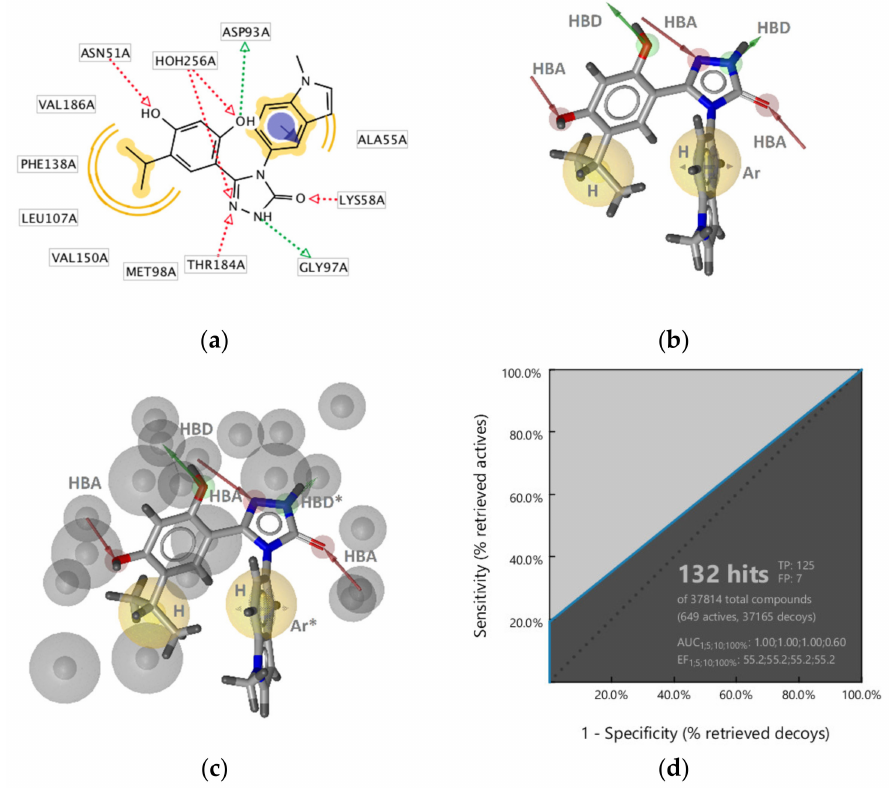
Figure 8. 3D-structure-based interactions of the inhibitor ganetespib derived from an Hsp90 X-ray structure (PDB ID: 3TUH). ( a ) 2D-depiction with binding site interaction partners and ( b ) 3D- depiction of the directly derived SB-pharmacophore model; ( c ) The refined SB-Hsp90-Model-1, ( d ) Receiver operating characteristic (ROC) plot (curve shown in blue) derived from virtually screen- ing 37,814 compounds (649 Hsp90 actives and 37,165 decoys) with SB-Hsp90-Model-1. TP = true positives; FP = false positives; AUC = area under the curve; EF = enrichment factor. Displayed phar- macophore features are: hydrophobic (H, yellow spheres), aromatic (Ar, blue disc), hydrogen bond donor (HBD, green arrow), and hydrogen bond acceptor (HBA, red arrow). Optional pharmacophore features are marked with